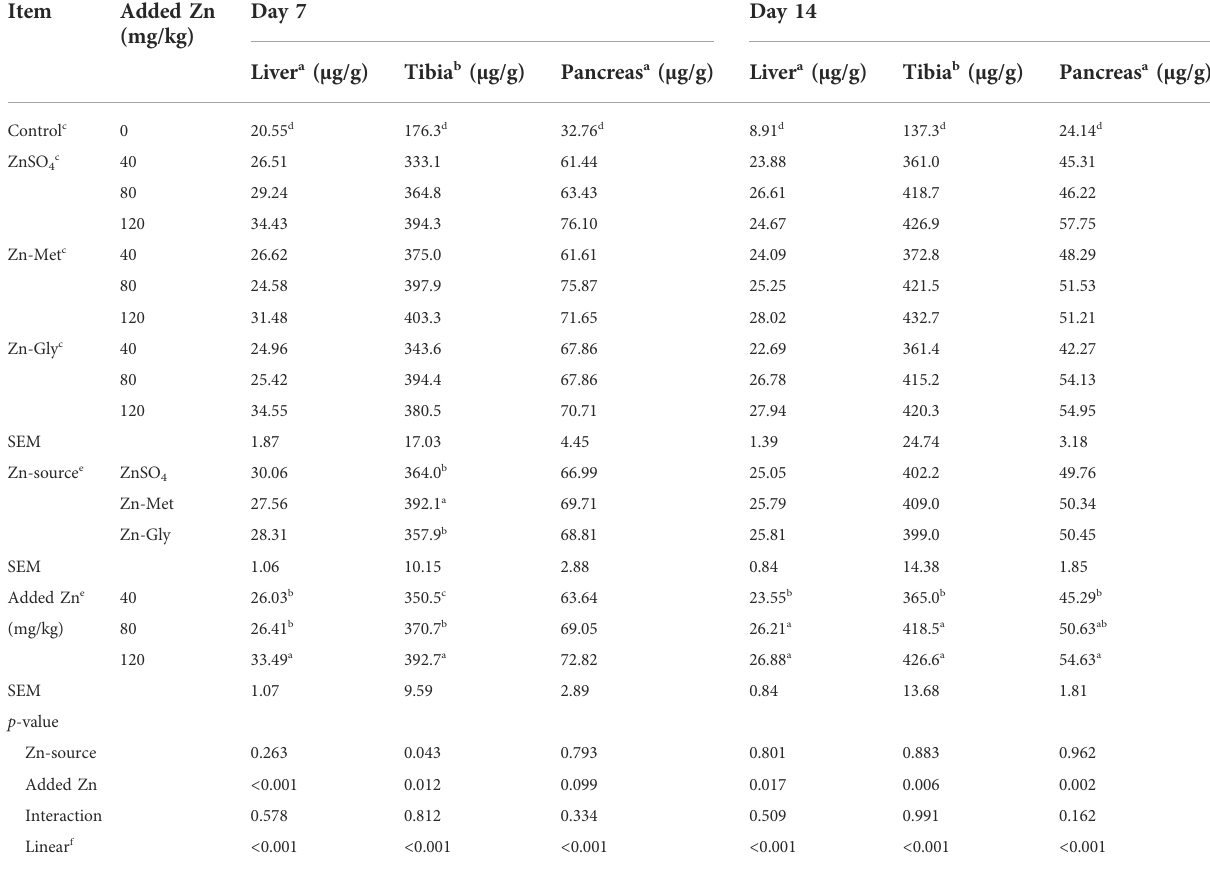
TABLE 4 Effects of supplemental zinc source and zinc level on zinc concentration in different tissues of broilers.